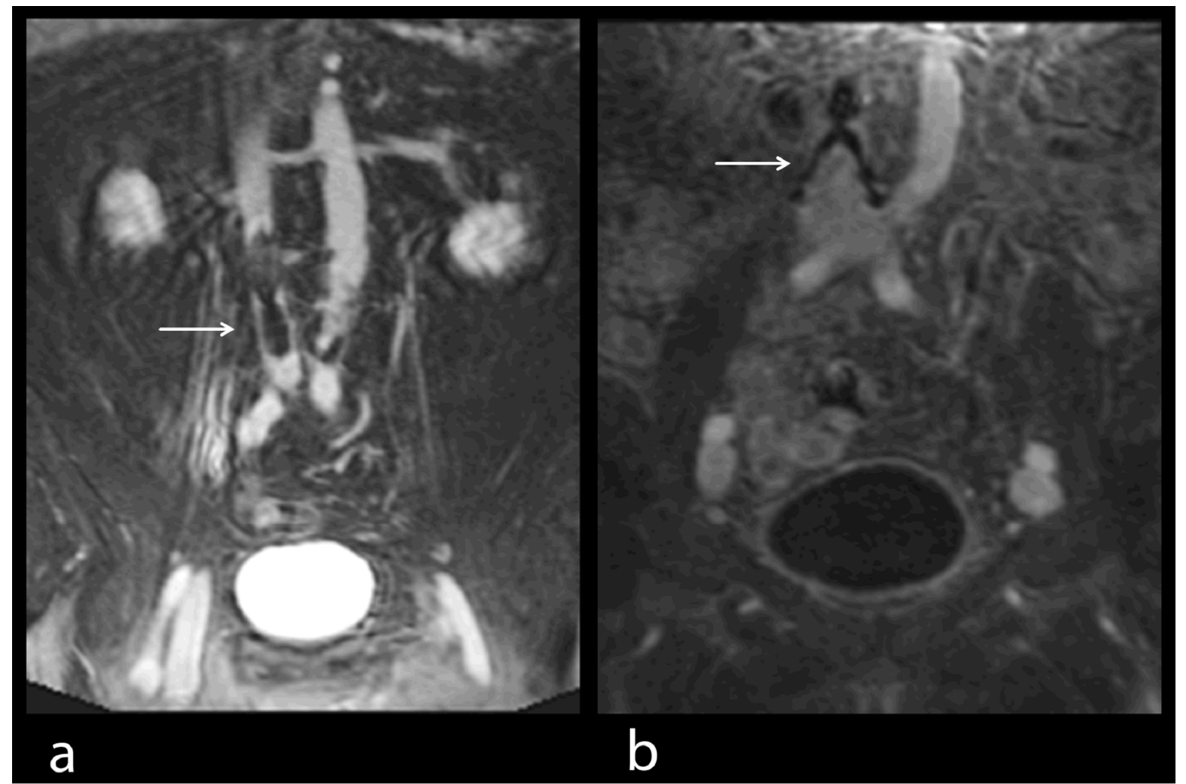
Figure 6. ( a ) MRV in a 32-year-old female patient. Optease ® filter (see arrow) with a captured thrombus at the follow-up examination. Good examination quality; ( b ) MRV in a 43-year-old male patient. Celect ® filter (see arrow) in the VCI to prevent further pulmonary embolism.